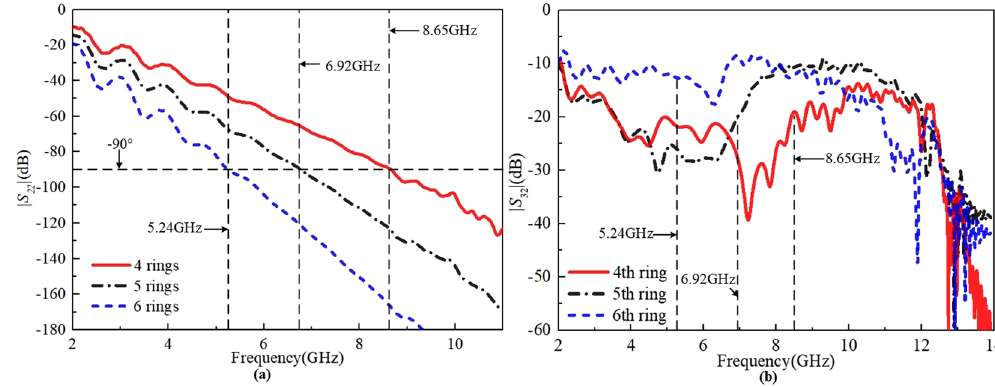
Figure 6. ( a ) The phase of 4th, 5th, and 6th half oval-ring transmission line. ( b ) The comparison of | S 32 | by adding a 200 Ω resistor across different half oval-ring